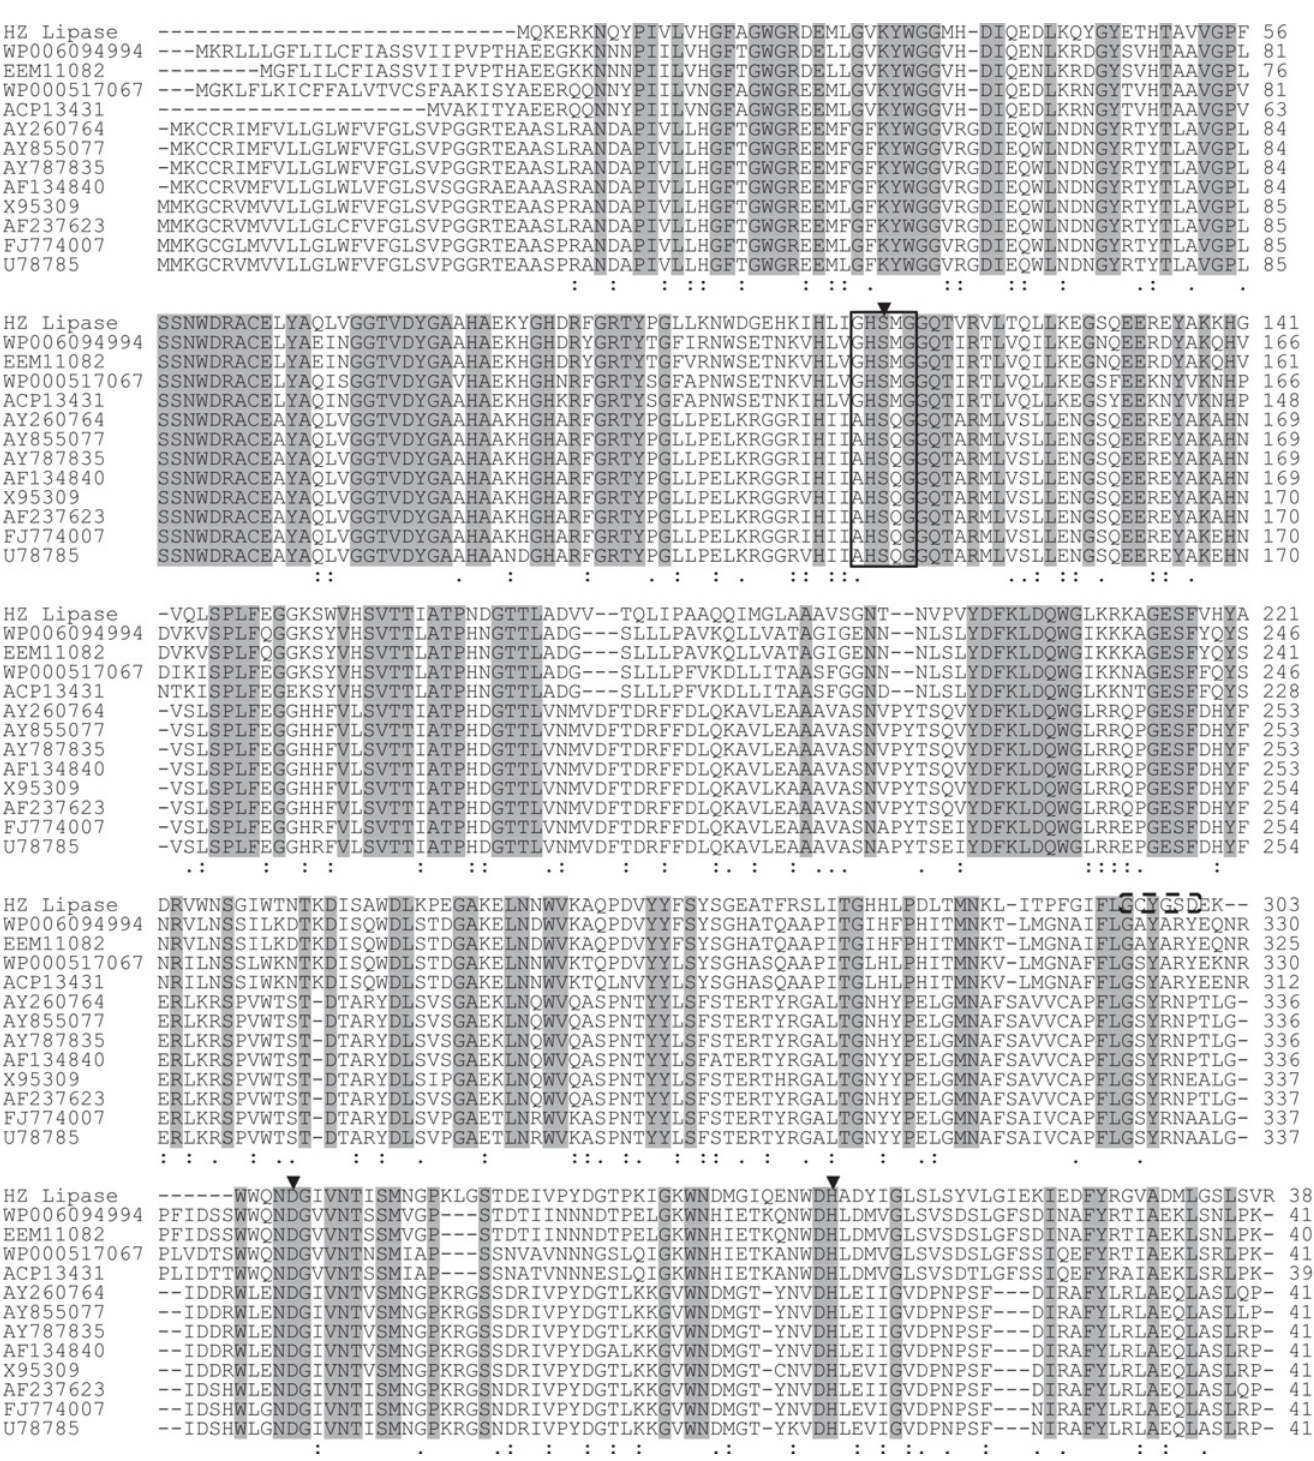
PLOS ONE | DOI:10.1371/journal.pone.0149851 March 2,